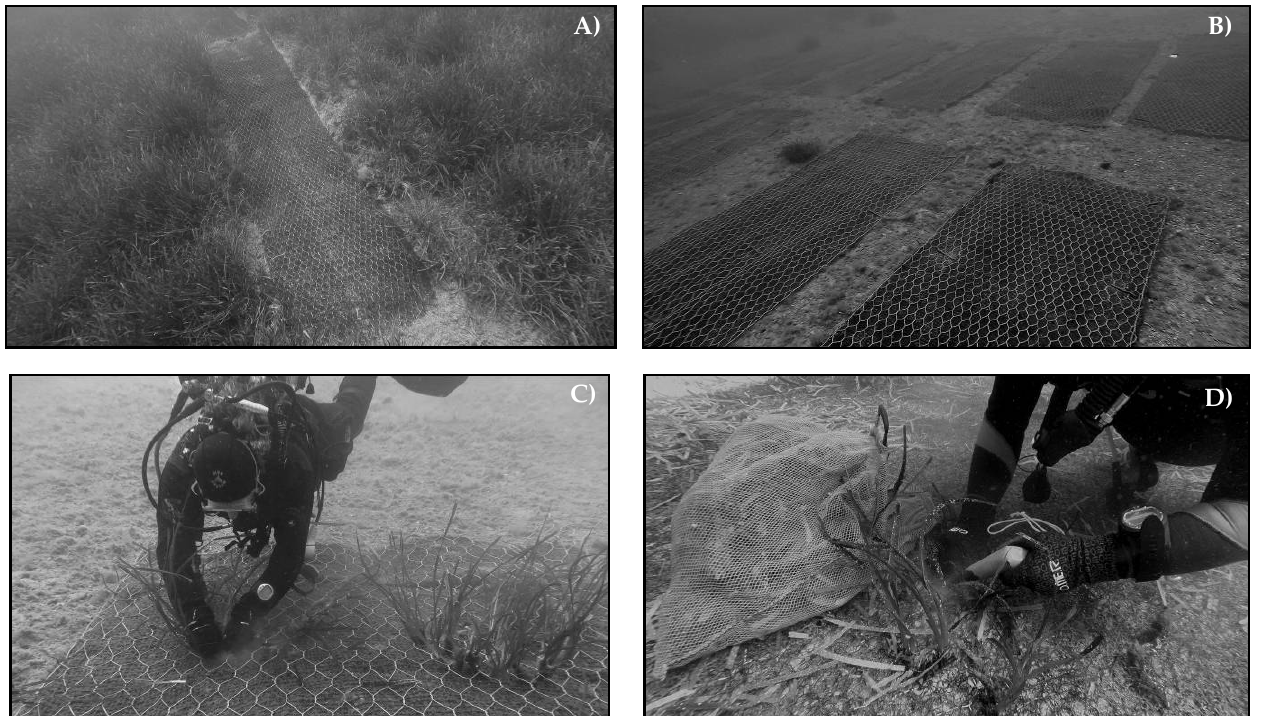
Figure 5. Mats positioned on the bottom at Capo Carbonara ( A ) and at Elba Island ( B ) and manual inclusion of cuttings in the mat ( C , D